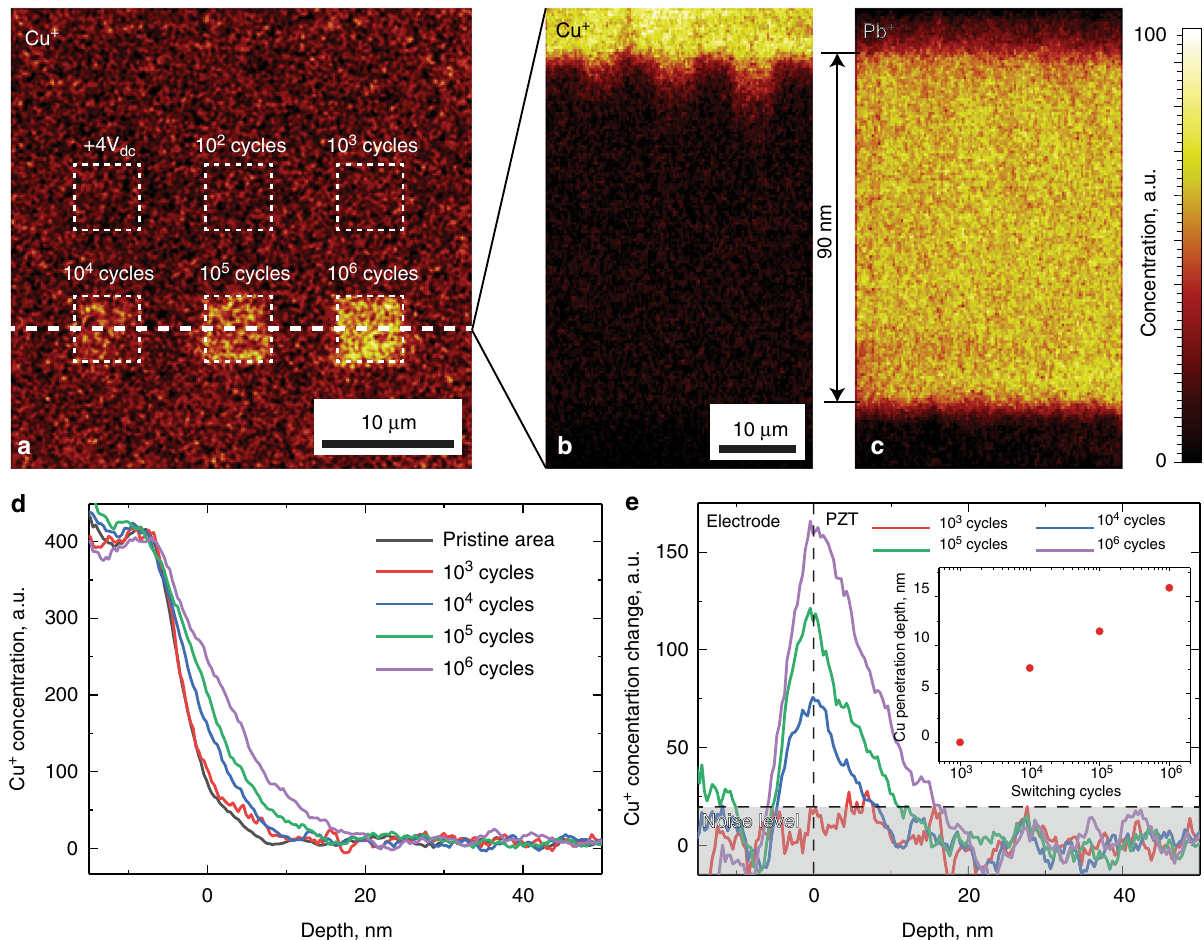
Fig. 4 ToF-SIMS investigation of the chemical phenomena associated with fatigue in a PZT. a XY map of Cu + distribution averaged over fi rst 5 nm depth layer of PZT right underneath the electrode; b , c XZ cross-sections of b Cu + and c Pb + averaged over the area of regions cycled with 10 4 to 10 6 pulses. d Depth pro fi les of Cu + distribution averaged over the pristine and cycled regions. e Differential pro fi le of the Cu + concentration inside the cycled regions with respect to the pristine fi lm; (inset) Cu + penetration depth vs number of applied switching pulses